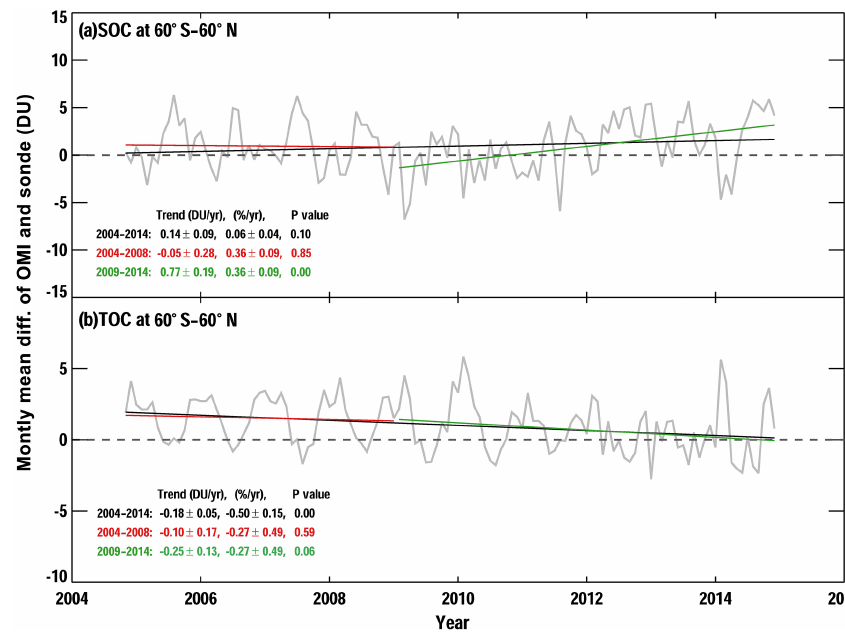
Figure 14. Same as Fig. 13 but for stratospheric ozone columns (SOCs) and tropospheric ozone columns